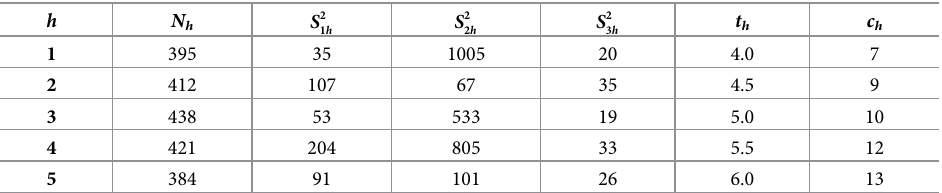
Table 2. Data related to strata and their characteristics for the complete response